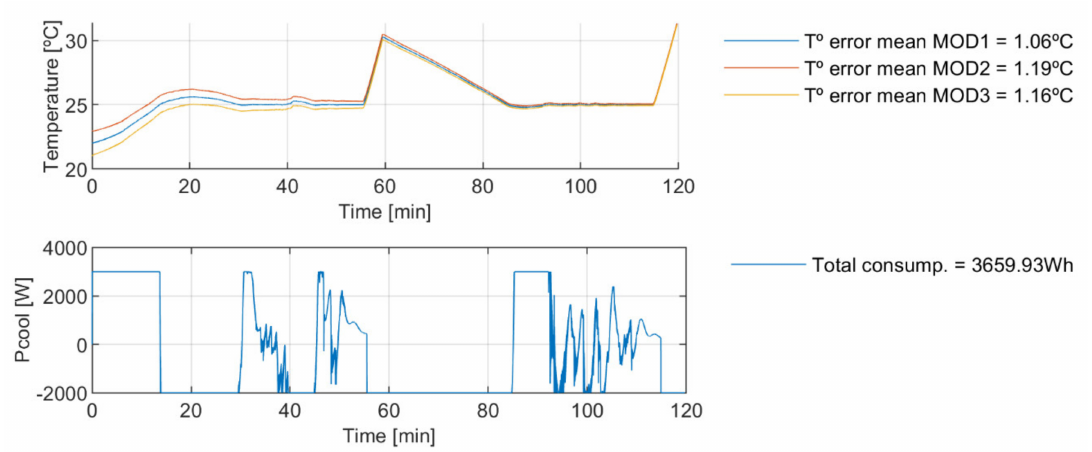
Figure 9. PID controller applied to the use